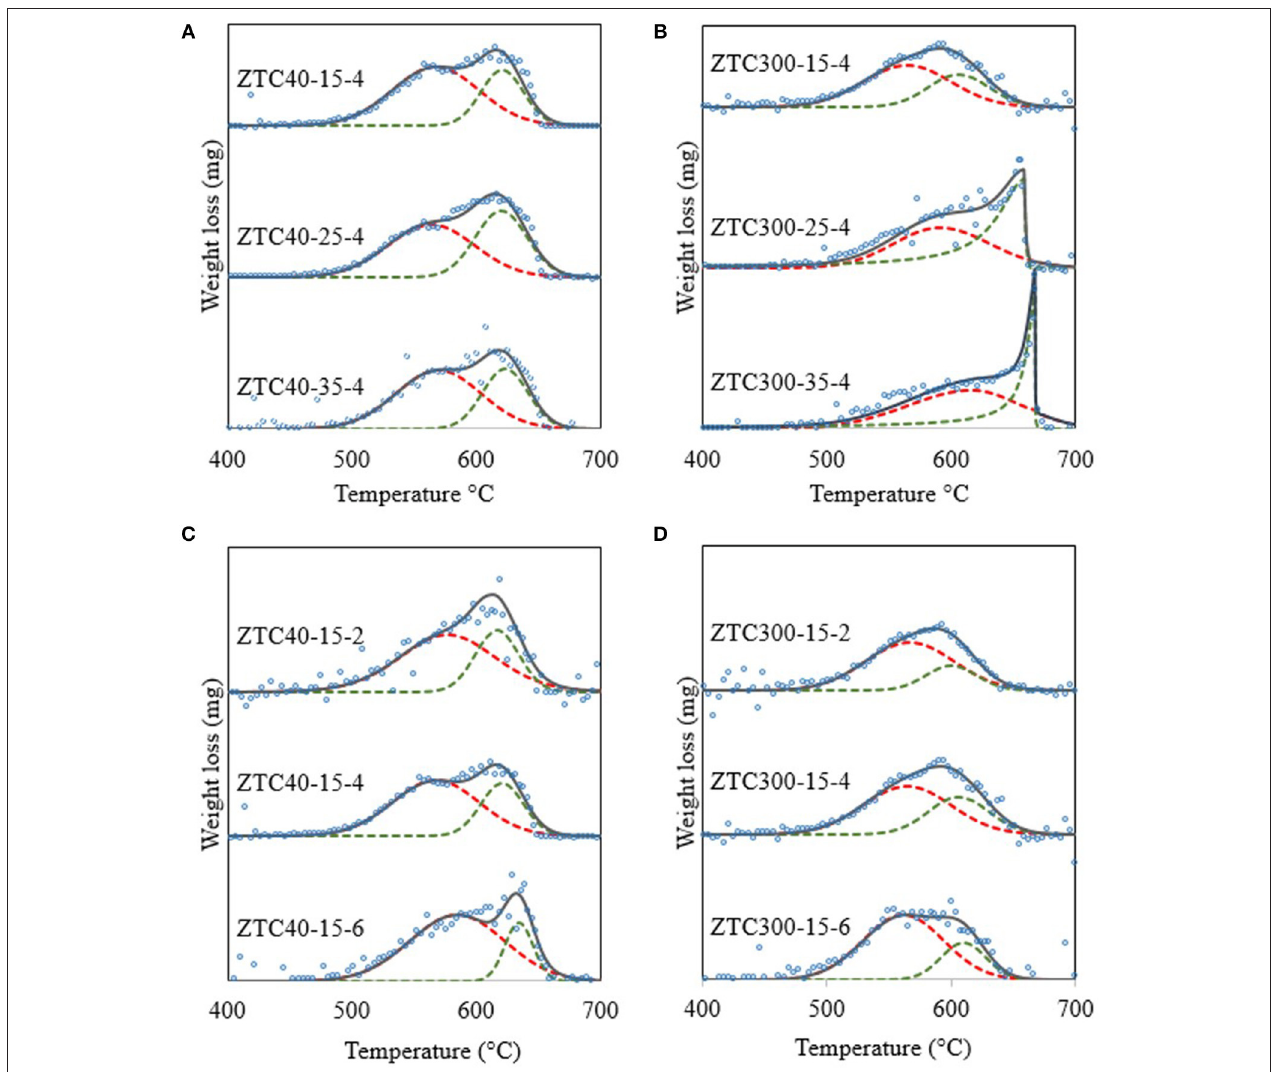
FIGURE 5 | DTG plots and peak fittings for the difference in acetylene concentration on (A) ZTC40 (B) ZTC300, and the difference in CVD time for (C) ZTC40 and (D) ZTC300. Open circles show the raw differentiated TG data. Dashed lines represent the peak fittings while the solid lines are the summation of the peak fittings.